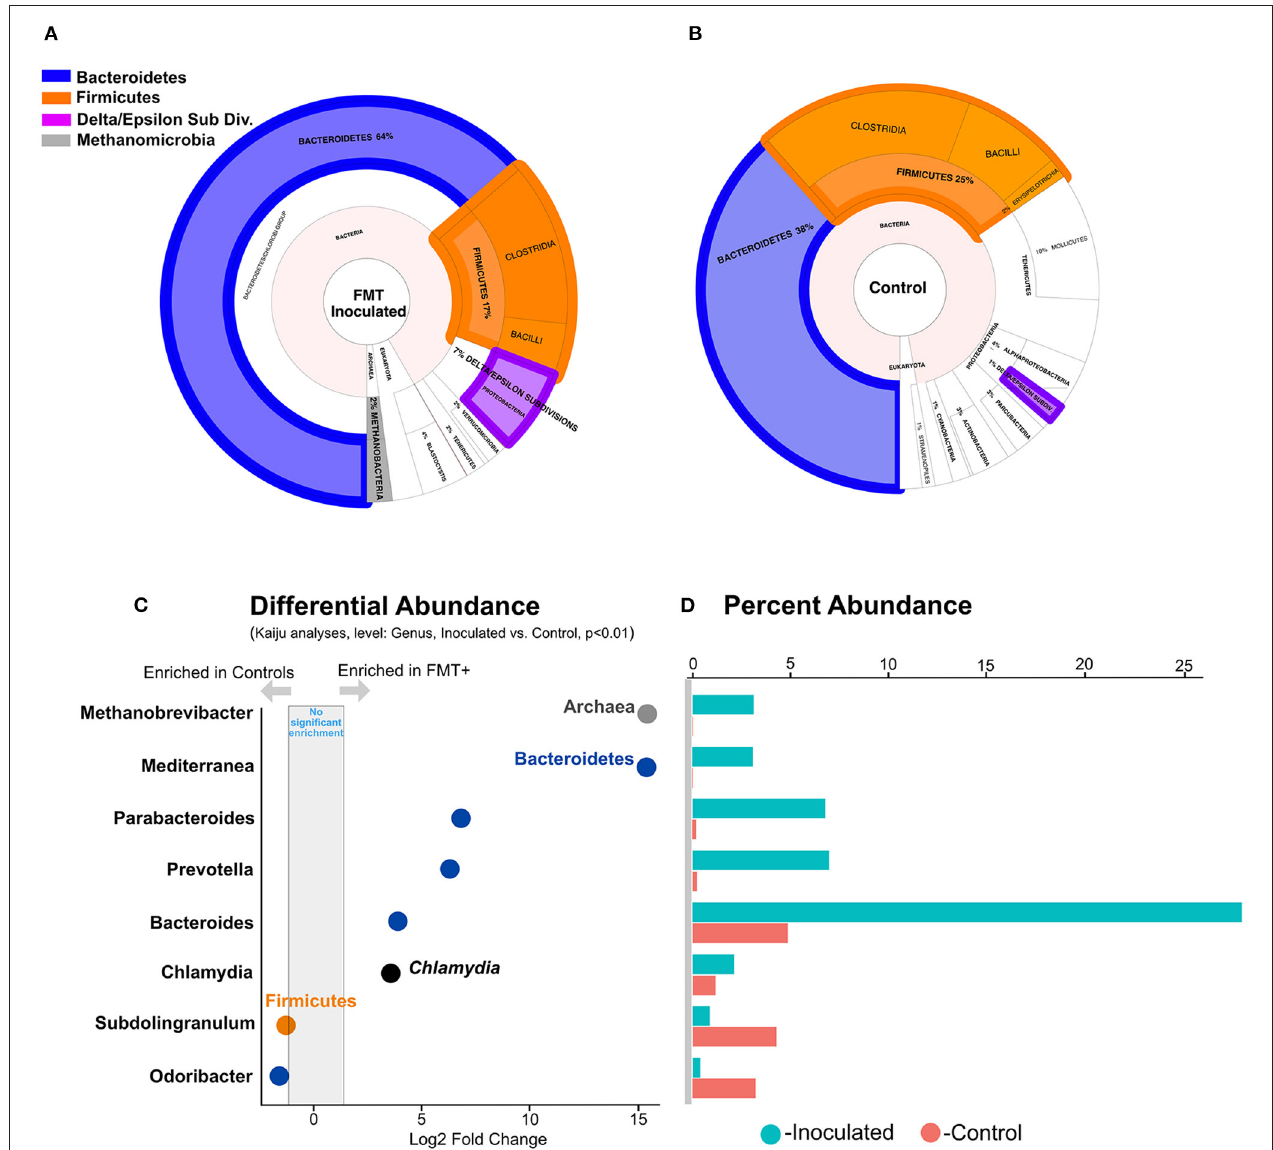
FIGURE 3 | Microbial community composition and relative abundance of taxa with significantly different relative abundances between inoculated and uninoculated groups. (A) Phylogenetic assignment of all contigs assembled from FMT metagenomes. (B) Phylogenetic assignment of all contigs assembled from control metagenomes. (C) Differentially enriched lineages in controls and FMT recipients. (D) Percent abundance of each significantly differentially abundant lineage in FMT inoculated and uninoculated